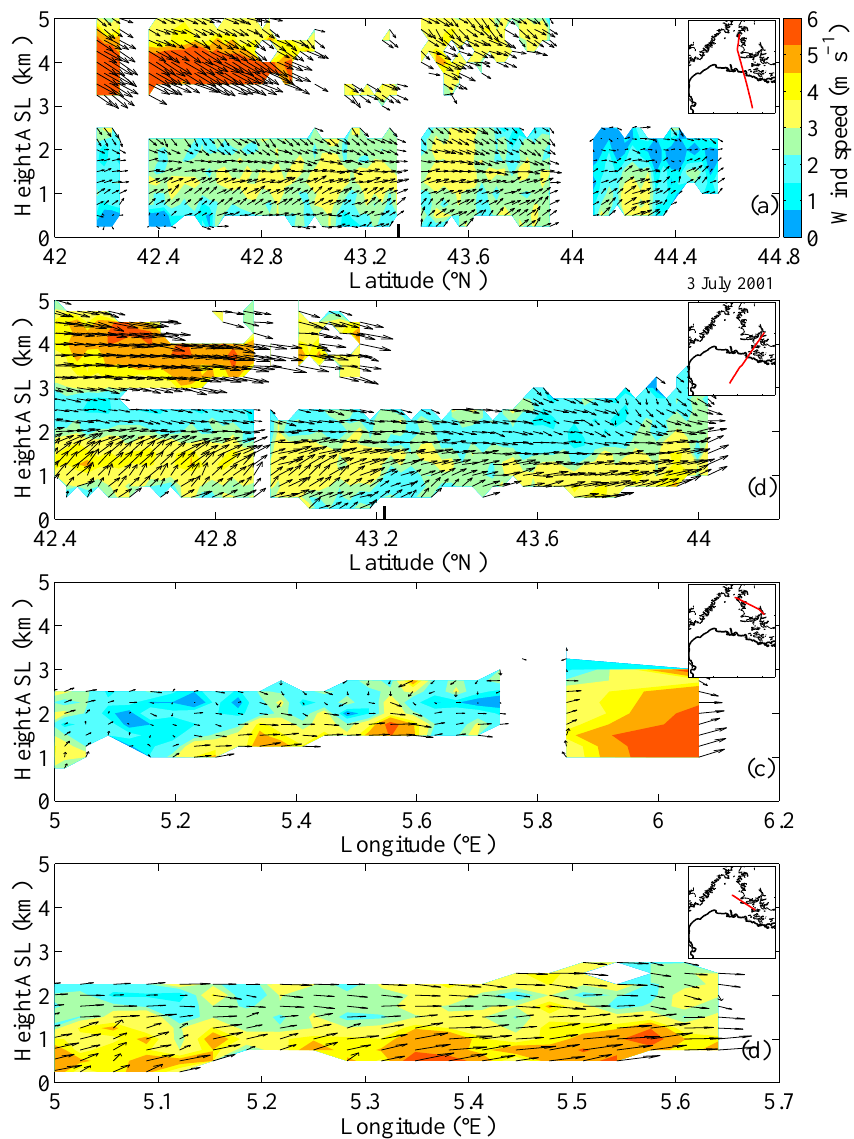
Fig. 7. Same as Fig. 4 but on 3 July 2001 at about 15:00 UTC (the time of the entire DLR Falcon 20 flight is given in Table 1). On panels (a) and (b) , the coastline is at about 43.33 ◦ N and 43.22 ◦ N, respectively.